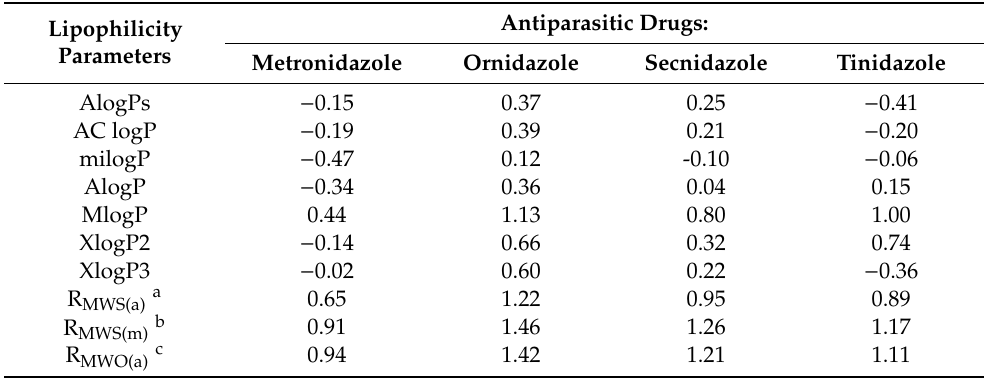
Table 1. Summary of the lipophilicity study of antiparasitic drugs by using the theoretical and RP-TLC